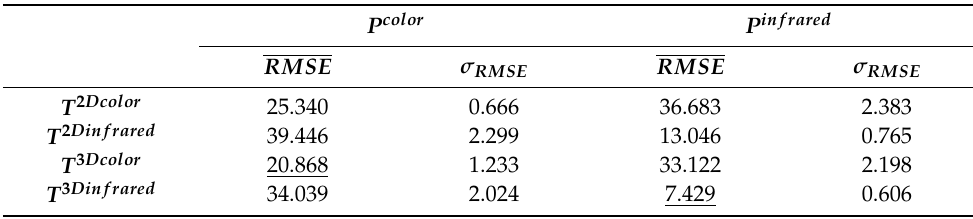
Table 2. Average and standard deviation of the RMSEs calculated between aligned and reference point clouds with dynamic target, where the calibration techniques have been applied [mm]. The best results of RMSE are underlined.